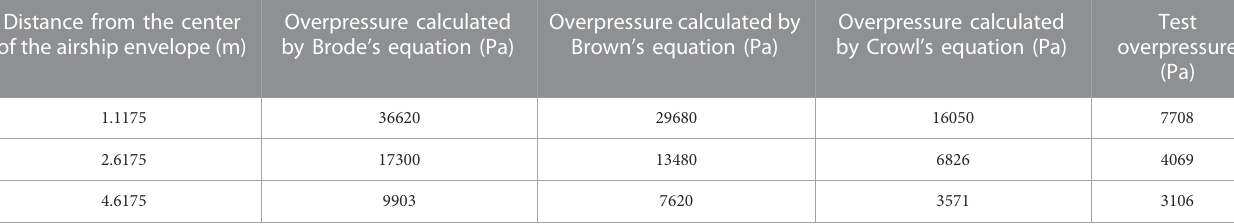
Overpressure calculated by Brown ’ s equation (Pa)